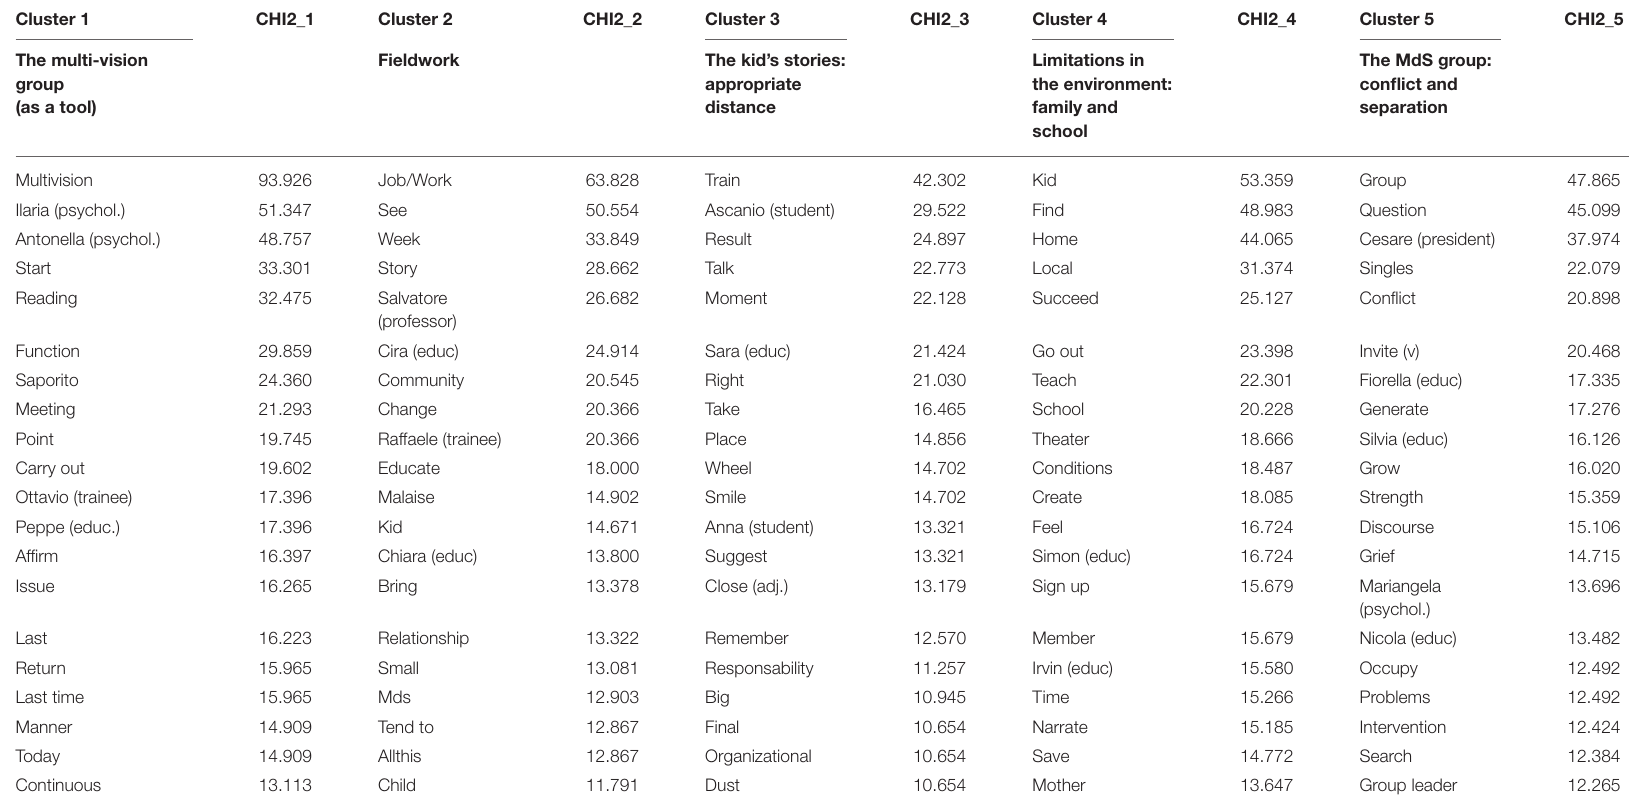
TABLE 1 | Pre-pandemic corpus (T1): the clusters’ specific vocabularies. Cluster